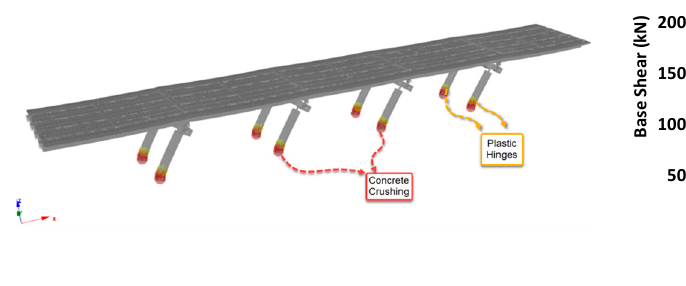
( b ) Figure 13. Pushover analysis results in the transverse (Y) direction: ( a ) deformed shape and damage locations, and ( b ) capacity curves of the one bent and the whole bridge. 5.3. Assessment of Seismic Response Dynamic time history analyses were conducted to provide insight into the seismic response of the bridge under the effect of earthquake records representing the seismicity of the study area [31]. This study considered fourteen input ground motions representing seven far-field and seven near-source earthquake records. These earthquakes were deemed suitable for the study area and were used in previous vulnerability assessment studies of structures [35–37,49]. The means of the selected input ground motions match the means of 40 earthquake records used in the previous seismic assessment studies for the study area. For each adopted seismic scenario, Figure 14 compares the response spec- tra of the 20 input ground motions previously used in seismic assessment studies and their mean, with the mean of the earthquake records selected for the present study. The presented comparison in Figure 14 confirms that the precise selection of earthquake rec- ords to represent each seismic scenario helped to reduce the number of analyses without compromising accuracy. The earthquake records representing the far-field seismic sce- nario were scaled to different intensities, starting from the design intensity (i.e., 0.16 g or 1× Design) up to 6.0× Design, with a step of 0.16 g. The near-field records were also scaled